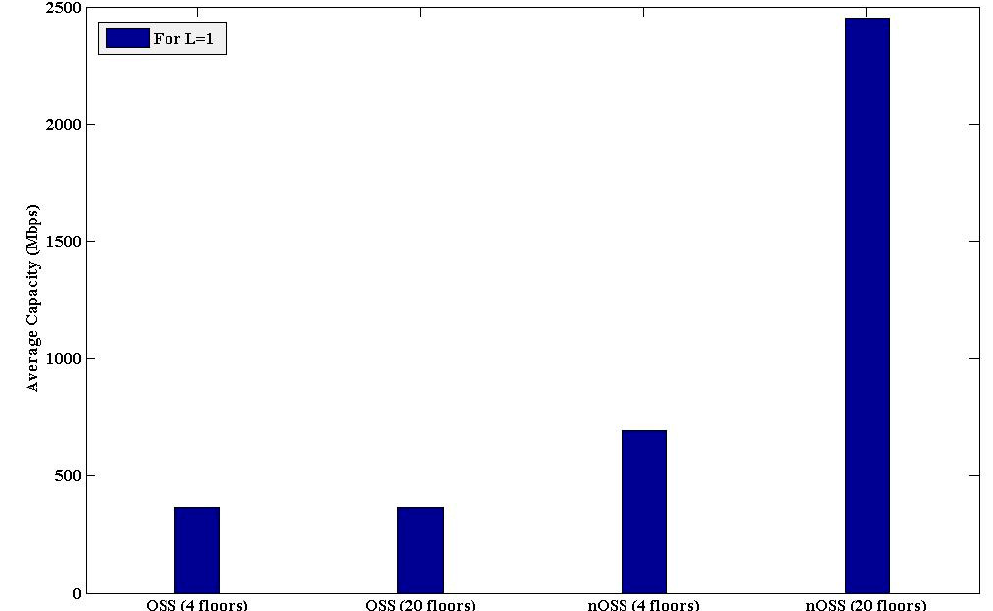
Figure 4. Capacity responses of OSS and nOSS of aTMS for L = 1.